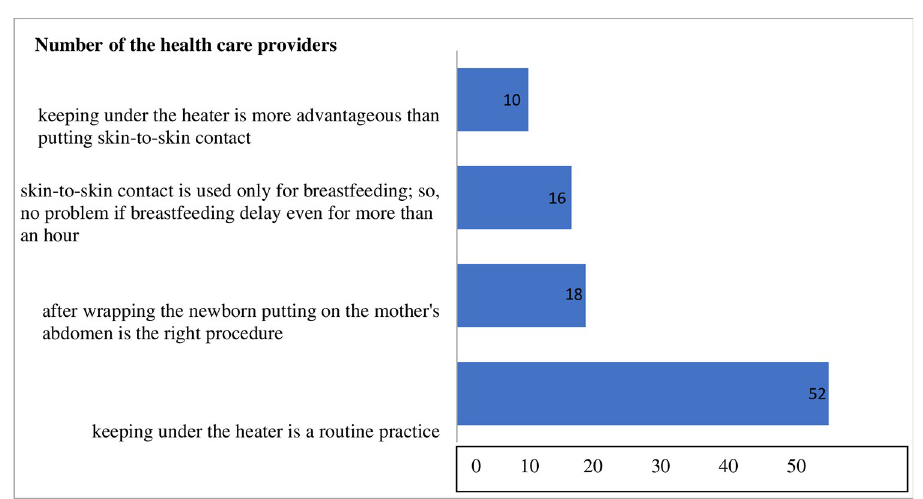
Fig 1. Reasons for not practicing mother-new born skin-to-skin contact of health care providers giving new born care during observation in Ilu Abba Bor and Bunno Beddelle zones health facilities, Oromia, Ethiopia